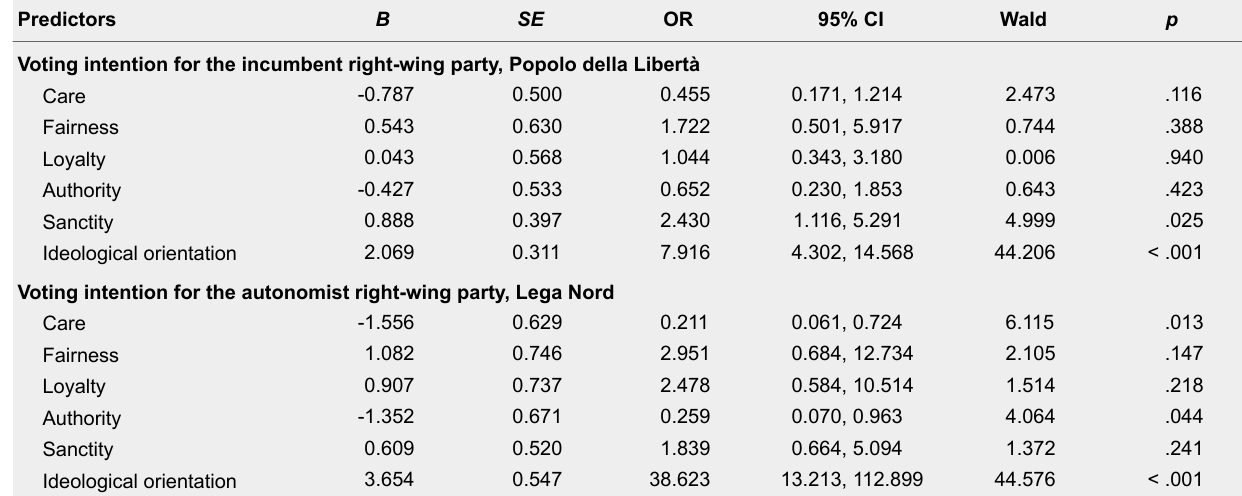
Nominal Regression of Voting Intention in 2010 on Moral Foundation Endorsement and Ideological Orientation, Study 1 (N = 216) Predictors B SE OR p Voting intention for the incumbent right-wing party, Popolo della